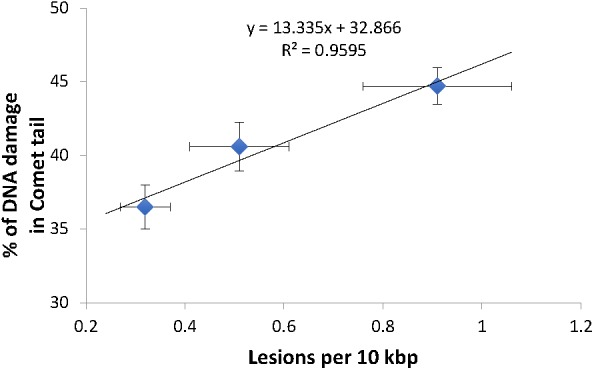
High correlation between the DNA damage level from both comet assay and S-XL-qRT-PCR assay. Both comet assay and S-XL-qRT-PCR DNA damage assay are able to detect significant dose-dependent increase in DNA damage in animals irradiated with 0, 20, and 40 kRad γ-radiation. Each point is a mean of minimum 55 comets (for data plotted in Y-axis) or minimum of 12 replicates (for data plotted on X-axis).